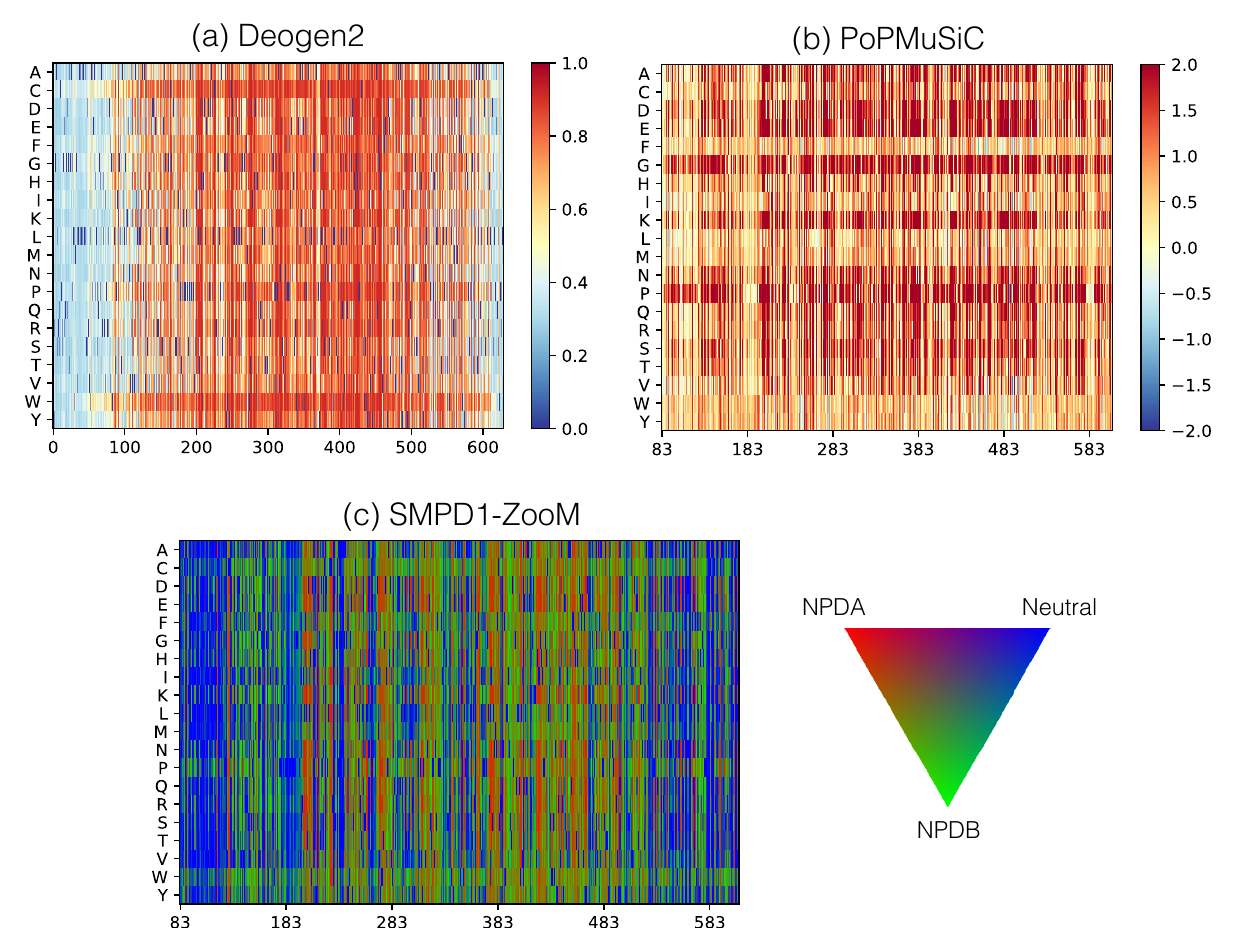
Figure 5. Heatmaps of the scores of all possible amino acid substitutions as a function of the sequence position using ( a ) the 2-state deleteriousness predictor DEOGEN2; ( b ) the ∆∆ G (in kcal/mol) predictor PoPMuSiC; ( c ) the 3-state deleteriousness predictor SMPD1-Zoom. The color scale represents: ( a ) red: deleterious and blue: neutral; ( b ) red: destabilizing and blue: stabilizing; ( c ) red: NPDA-associated, green: NPDB-associated, blue: neutral. Note that the sequence on the abscissa is shorter for SMPD1-ZooM and PoPMuSiC than for DEOGEN2 as the former correspond to the X-ray structure and the latter to the full